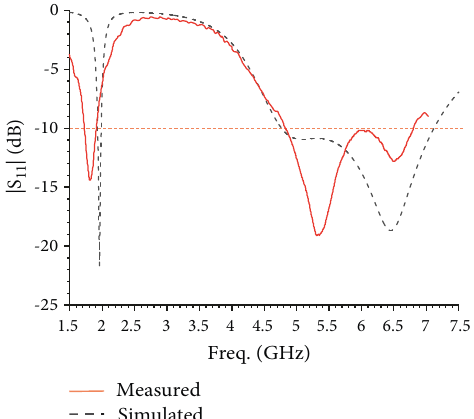
Figure 5: Reflection Coefficient response of the proposed OBS antenna.